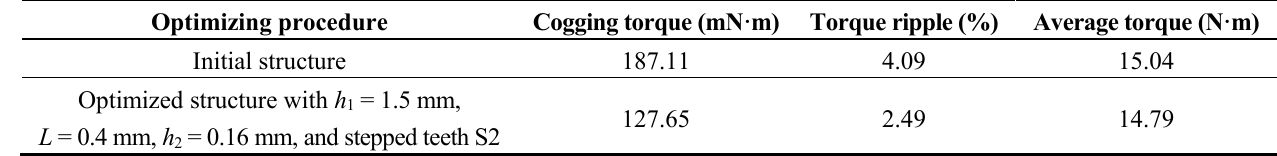
Table 5. Torque characteristics before and after optimizing the stepped and notched teeth combination.